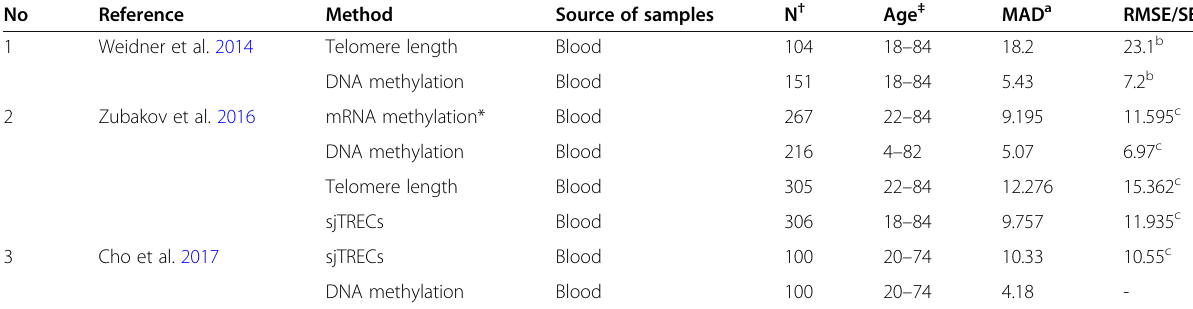
Table 1 Selected methods of forensic age